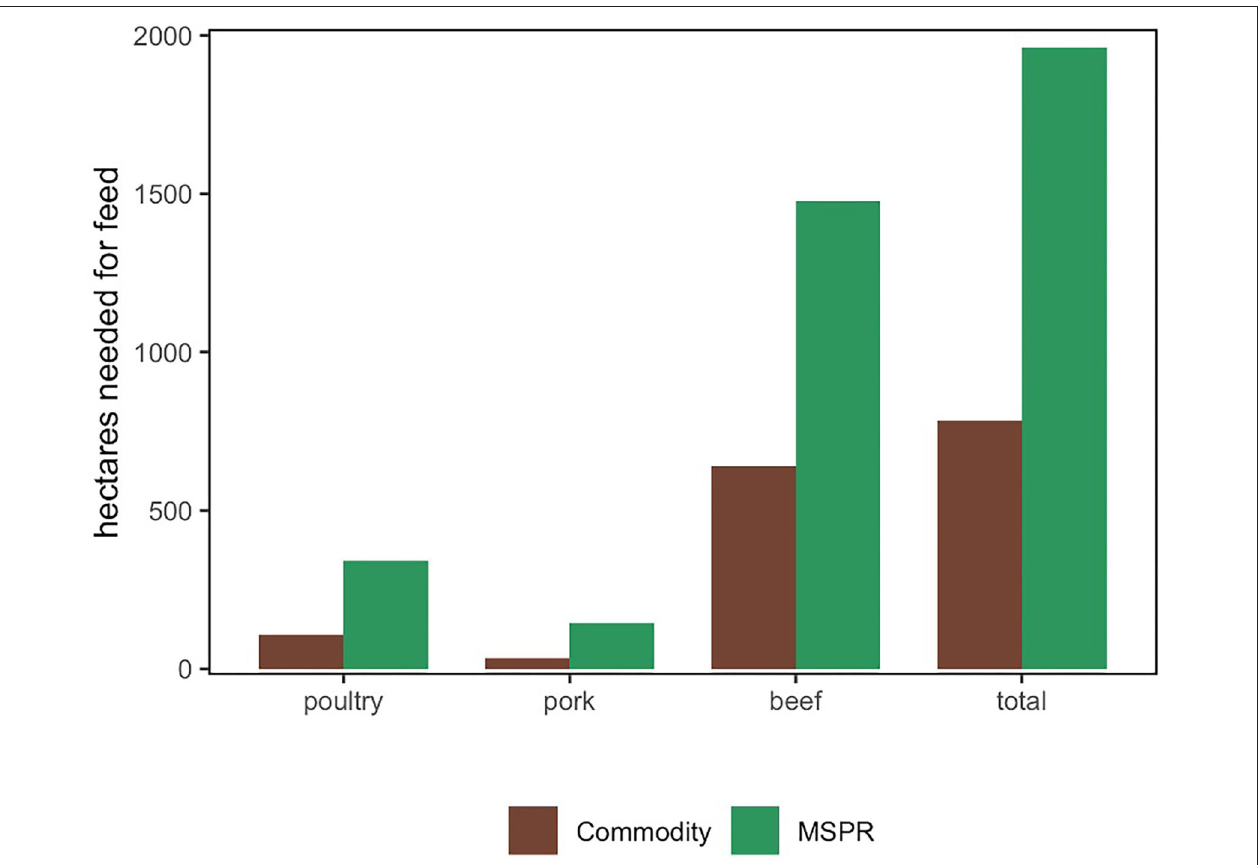
FIGURE 4 | Comparison of a Commodity and Multi-Species Pasture Rotation (MSPR) for land needed to graze beef and supply feed for poultry (275,242kg), pork (65,049kg) and beef (268,777kg) similar to outputs of monitored MSPR